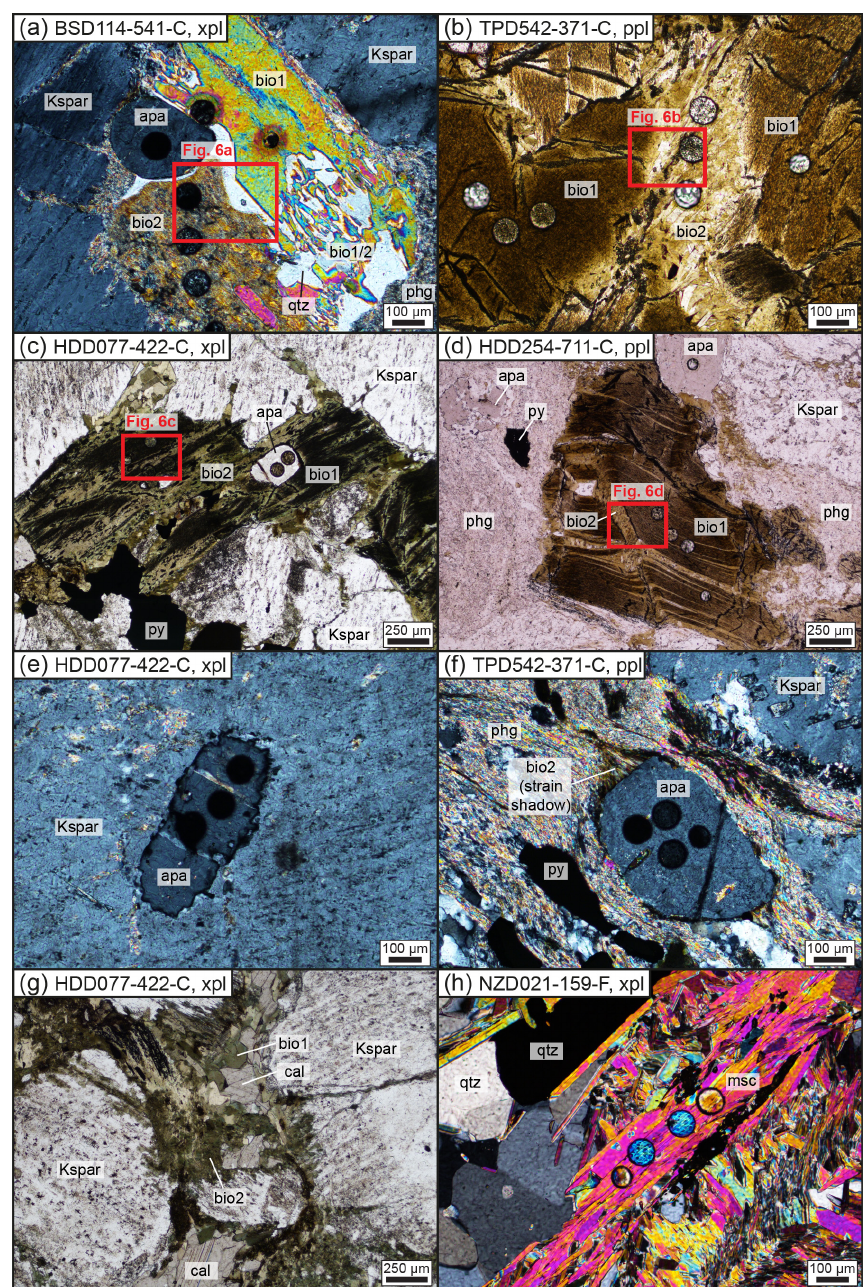
Figure 3. Thin section photomicrographs in transmitted light showing detailed mineral relationships. (a) Biotite in various stages of recrys- tallization, from euhedral biotite 1 to partly recrystallized biotite 1 and 2 to fully recrystallized biotite 2, from BSD114-541-C. Note the association of unstrained quartz with recrystallization. (b) Recrystallized biotite 2 corridor between biotite 1 in TPD542-371-C. (c) Biotite 1 variably recrystallized to biotite 2, and associated with pyrite and apatite, all interstitial to K-feldspar phenocrysts from HDD077-422-C. (d) Biotite 2 recrystallized subparallel to the axial plane of folded biotite 1, situated in association with phengite and interstitial to K-feldspar phenocrysts, from HDD254-711-C. (e) Apatite (possibly magmatic and/or associated with assemblage 1) fully enclosed in K-feldspar phe- nocryst from HDD077-422-C. (f) Apatite (2) porphyroclast with rare strain shadow of biotite 2 and phengite, implying locally biotite 2 > apatite > phengite, from TPD542-371-C. Also note the close association of pyrite. (g) Carbonate ingress with recrystallization of biotite 1 to biotite 2, interstitial to K-feldspar from HDD077-422-C. (h) Euhedral muscovite in association with quartz, from NZD021-159-F. The abbre- viations used in the figure are as follows: apa – apatite; bio1 – euhedral, first generation biotite; bio1/2 – partly recrystallized biotite 1;